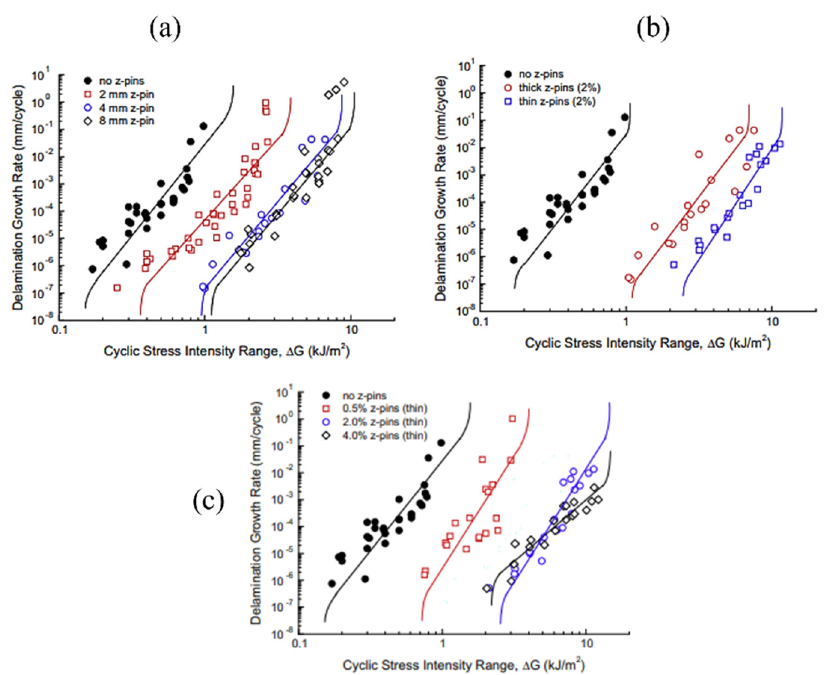
Figure 24. Effect of z-pin dimensions and volume on fatigue crack growth rate ( a ) Effect of length ( b ) Effect of diameter ( c ) Effect of volume [112].